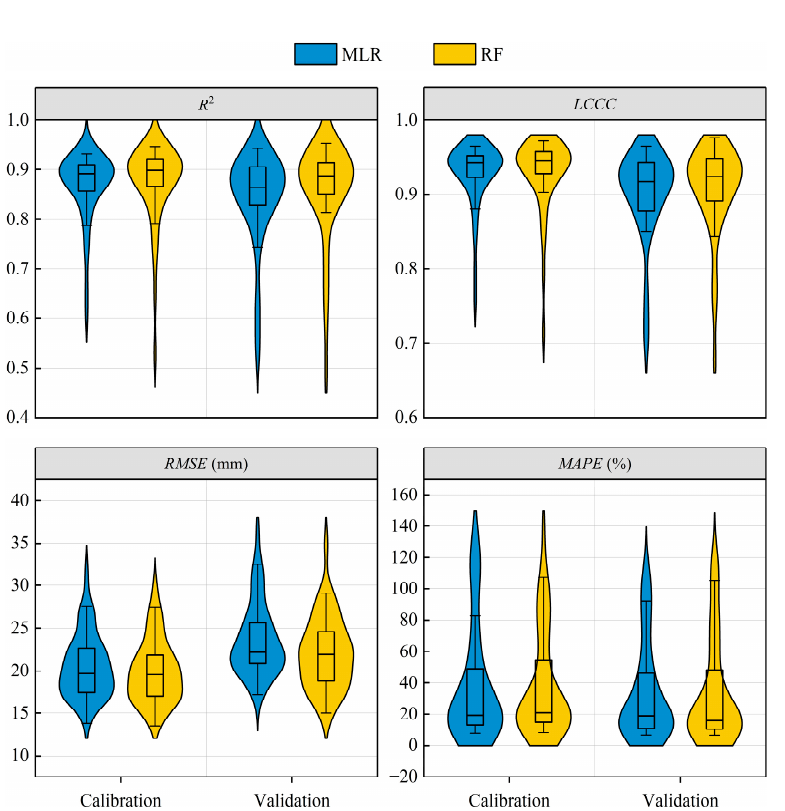
Figure 6. Results of R 2 , LCCC , RMSE, and MAPE to show performance of MLR- and RF-based models for site-specific D in northwestern China during the calibration and validation processes. The horizontal line inside the box indicates the median. The box boundary indicates the 25th and 75th percentiles, and the whiskers below and above the box indicate the 10th and 90th percentiles.